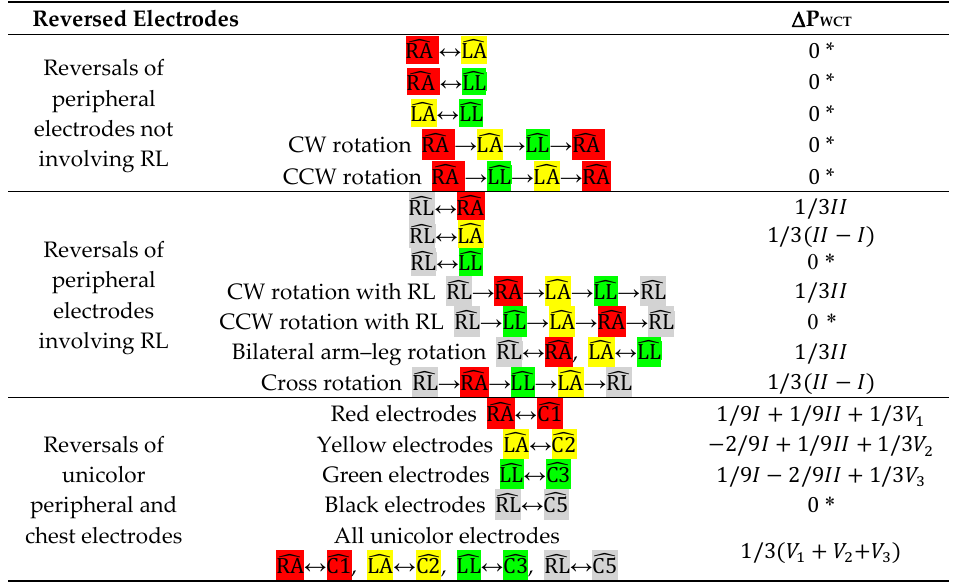
Figure 2. Classic depiction of the Einthoven’s triangle, WCT and lead vectors (I, II, Vx), projected in the frontal plane for correct electrode position ( a ) and their displacement (ˆI, (cid:98) II, ˆV X ) in case of four types of limb electrode reversals: ( b ) CW rotation of 3 active limb electrodes ( (cid:99) RA → (cid:99) LA → (cid:99) LL → (cid:99) RA); ( c ) CW rotation of 4 limb electrodes, including RL ( (cid:99) RL → (cid:99) RA → (cid:99) LA → (cid:99) LL → (cid:99) RL); ( d ) swap of an active limb electrode and chest electrode, illustrated for the green couple ( (cid:99) LL ↔ (cid:99) C3); ( e ) swap of the grounded and chest electrode, illustrated for the black couple ( (cid:99) RL ↔ (cid:99) C5). The text with red font color highlights the electrodes in wrong geometrical positions, and the swap matrix entries di ff erent from the identity matrix in ( a ). Table 1. Calculation of the WCT potential change from the recorded leads via the ‘WSMinv’ transformation (12), applying the swap matrices S in Tables 2–4.